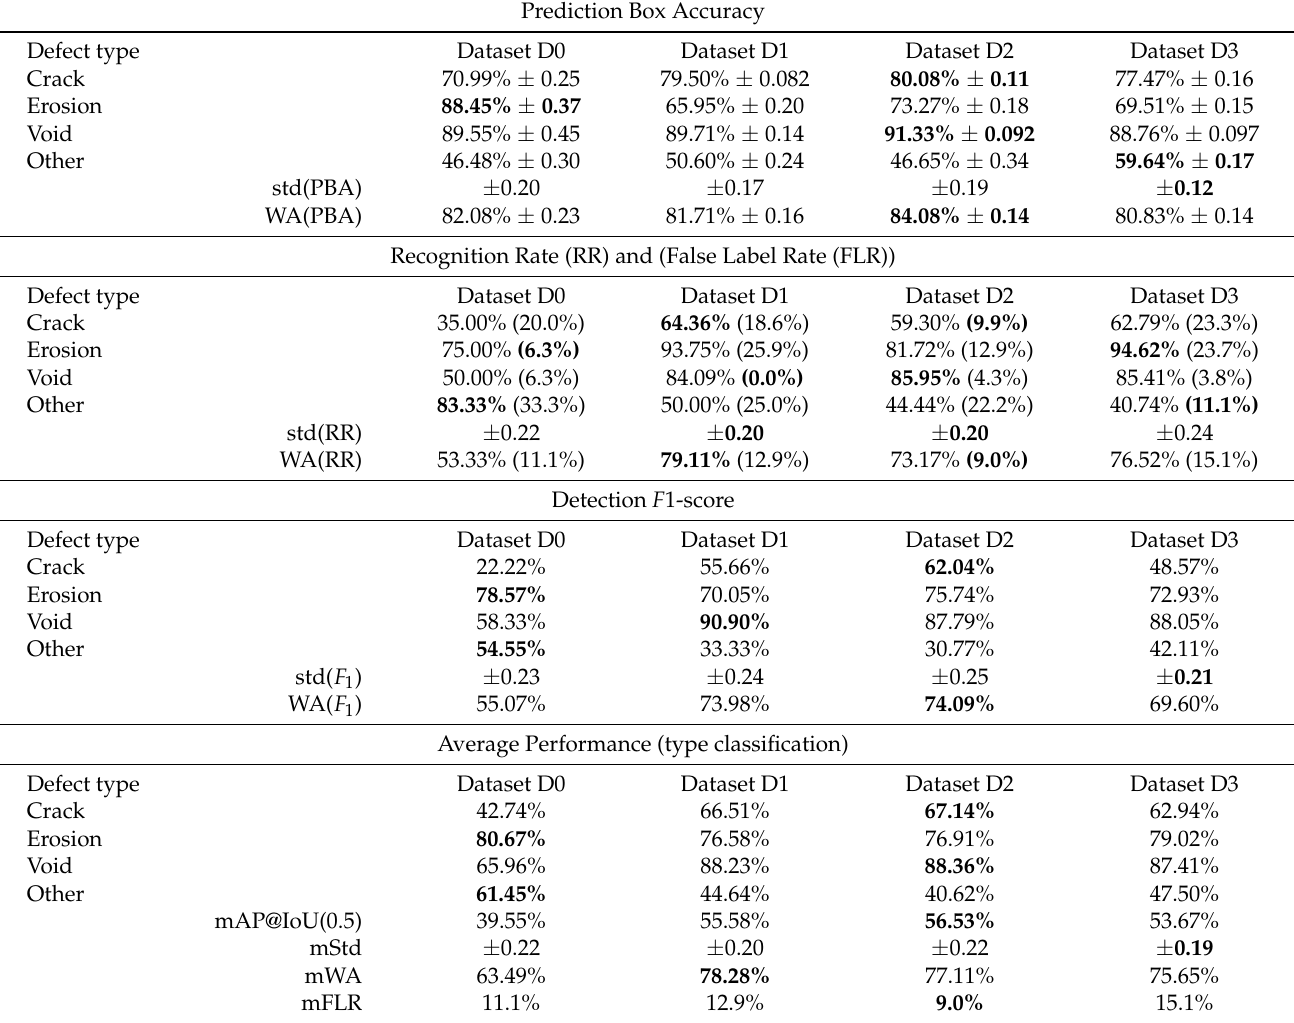
Table 6. YOLOv4: Performance evaluation on test dataset. WA is the weighted average as defined in (11). mWA is the mean WA of PBA, RR, and Detection F 1 -score. mStd is the mean std of PBA, RR, and Detection F 1 -score. mFLR is the weighted average of FLR across all defect types.